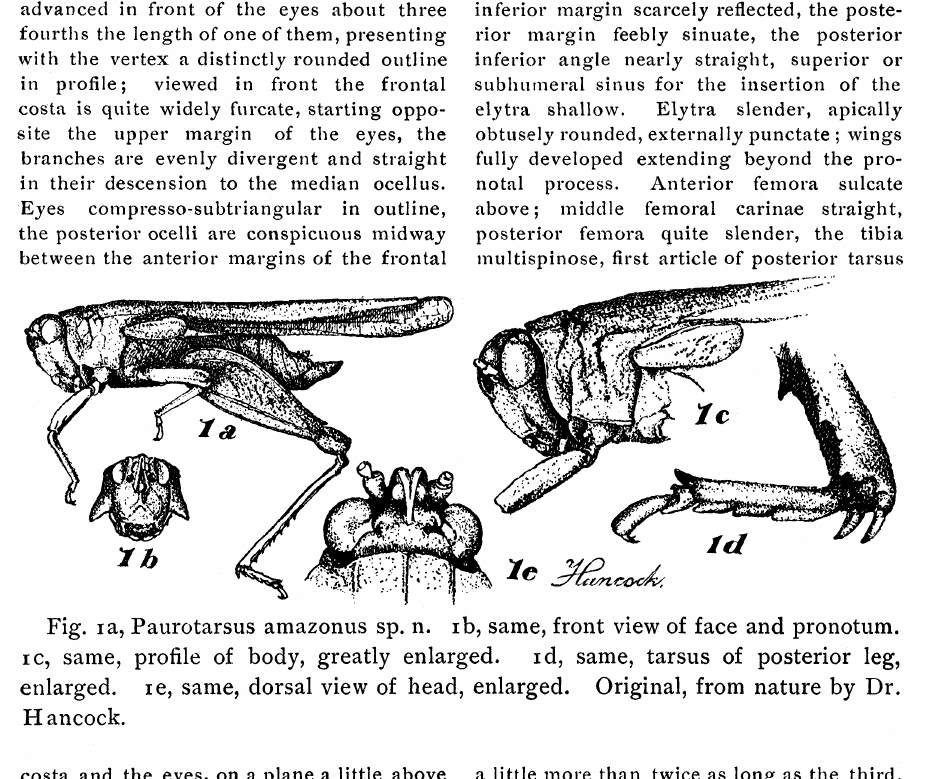
Fig. a, Paurotarsus amazonus sp. n. b, same, front view of face and pronotum. c, same, profile of body, greatly enlarged. d, same, tarsus of posterior leg, enlarged. e, same, dorsal view of head, enlarged. Original, from nature by